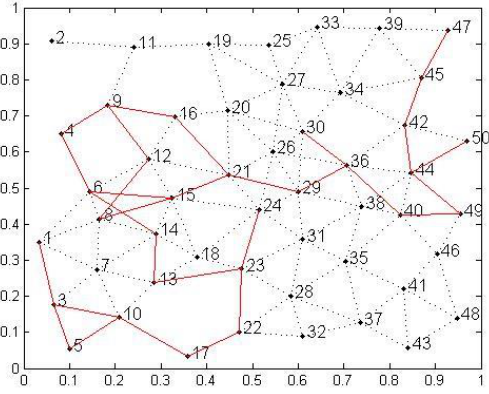
Table 2. Parameter-setting in experiments.